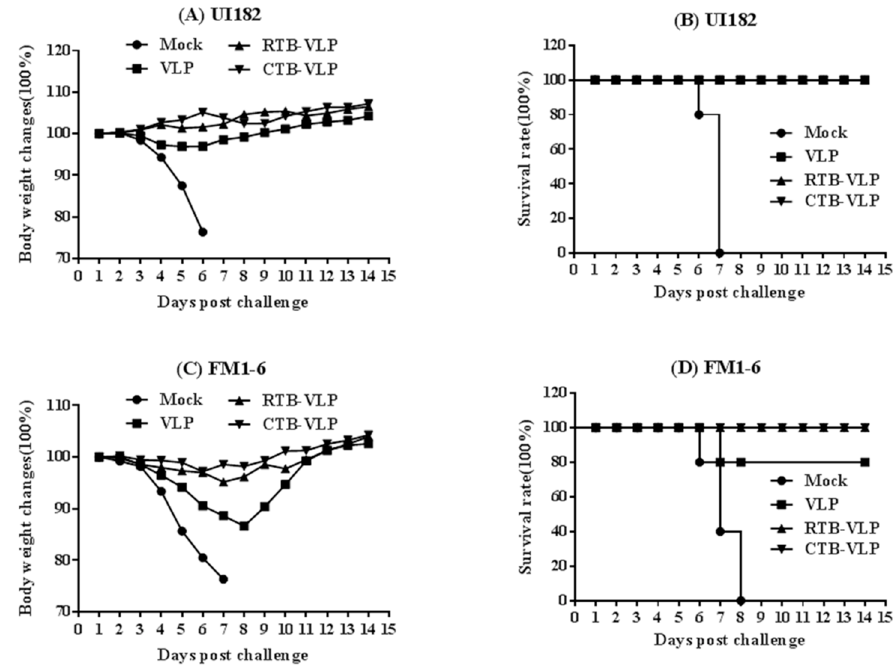
Figure 5. Morbidity and survival in mice immunized with cVLPs following challenge with UI182 or FM1-6 virus. Immunized mice (n = 5) were challenged with 10 MLD 50 of UI182 ( panels A,B ) or FM1-6 virus ( panels C,D ) 5 weeks after the first immunization. Mice were monitored daily for 14 days for body weight changes ( panels A,C ) and survival ( panels B,D ).